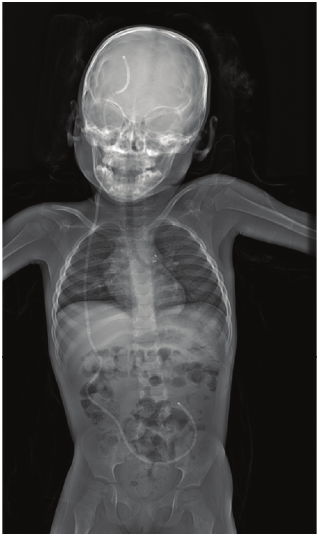
Figure 4: Example of the use of Lodox in VP shunt visualisation in paediatric